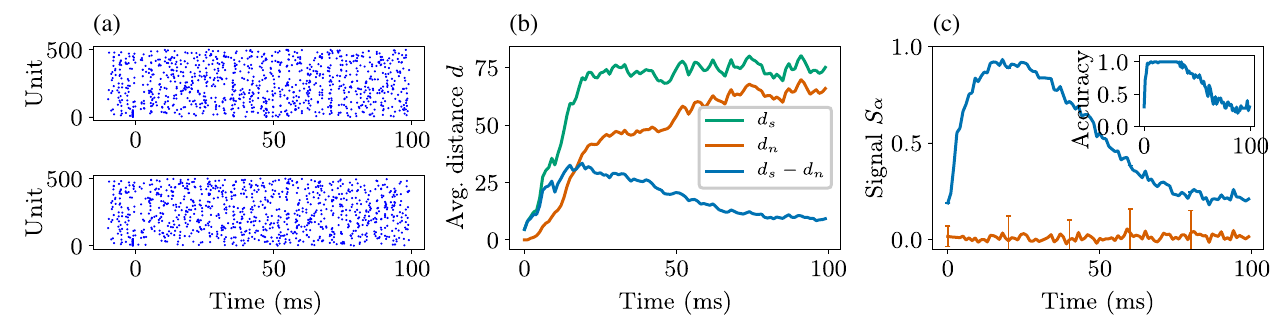
FIG. 11. Transient chaotic dimensionality expansion in a spiking network. (a) Raster plots of spiking activity in the network for two different patterns; average firing rate per neuron ν ≃ 19 Hz. Parameters N ¼ 500 , in-degree K ¼ 125 , weights J 10 ms; additional detail given in the Appendix 11. (b) Evolution of average Euclidean distance between membrane time constant τ m ¼ different patterns (green), noisy realizations of a pattern (dark orange), and the difference of the two (blue). (c) Signal of matching readout (blue), nonmatching readouts (dark orange), and classification performance